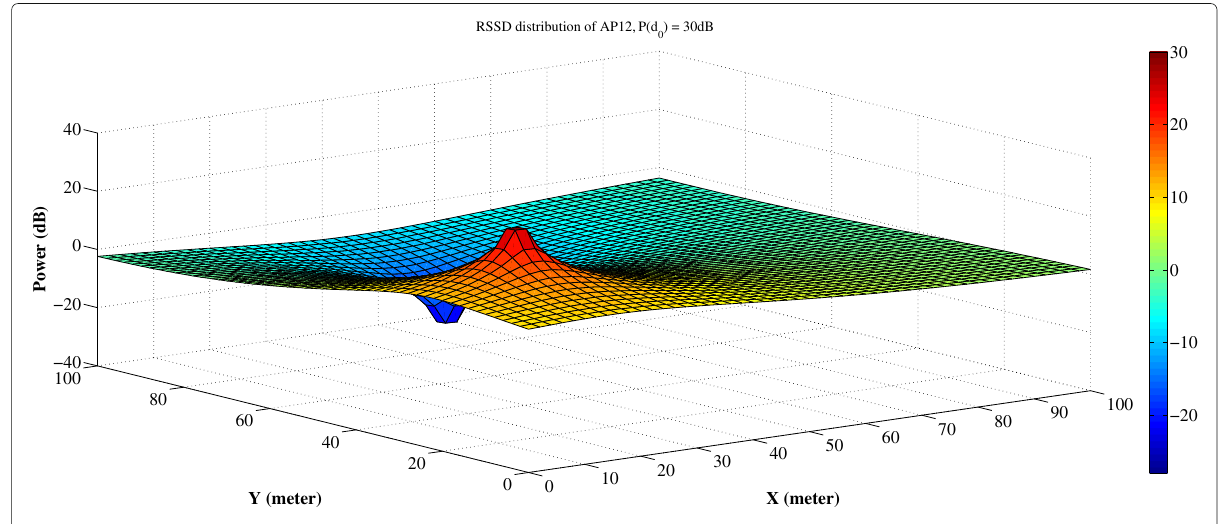
Fig. 11 RSSD distribution of AP12. P ( d 0 ) = 30 dB, α = 1.8, d = 2 m, and σ = 5.2 dB